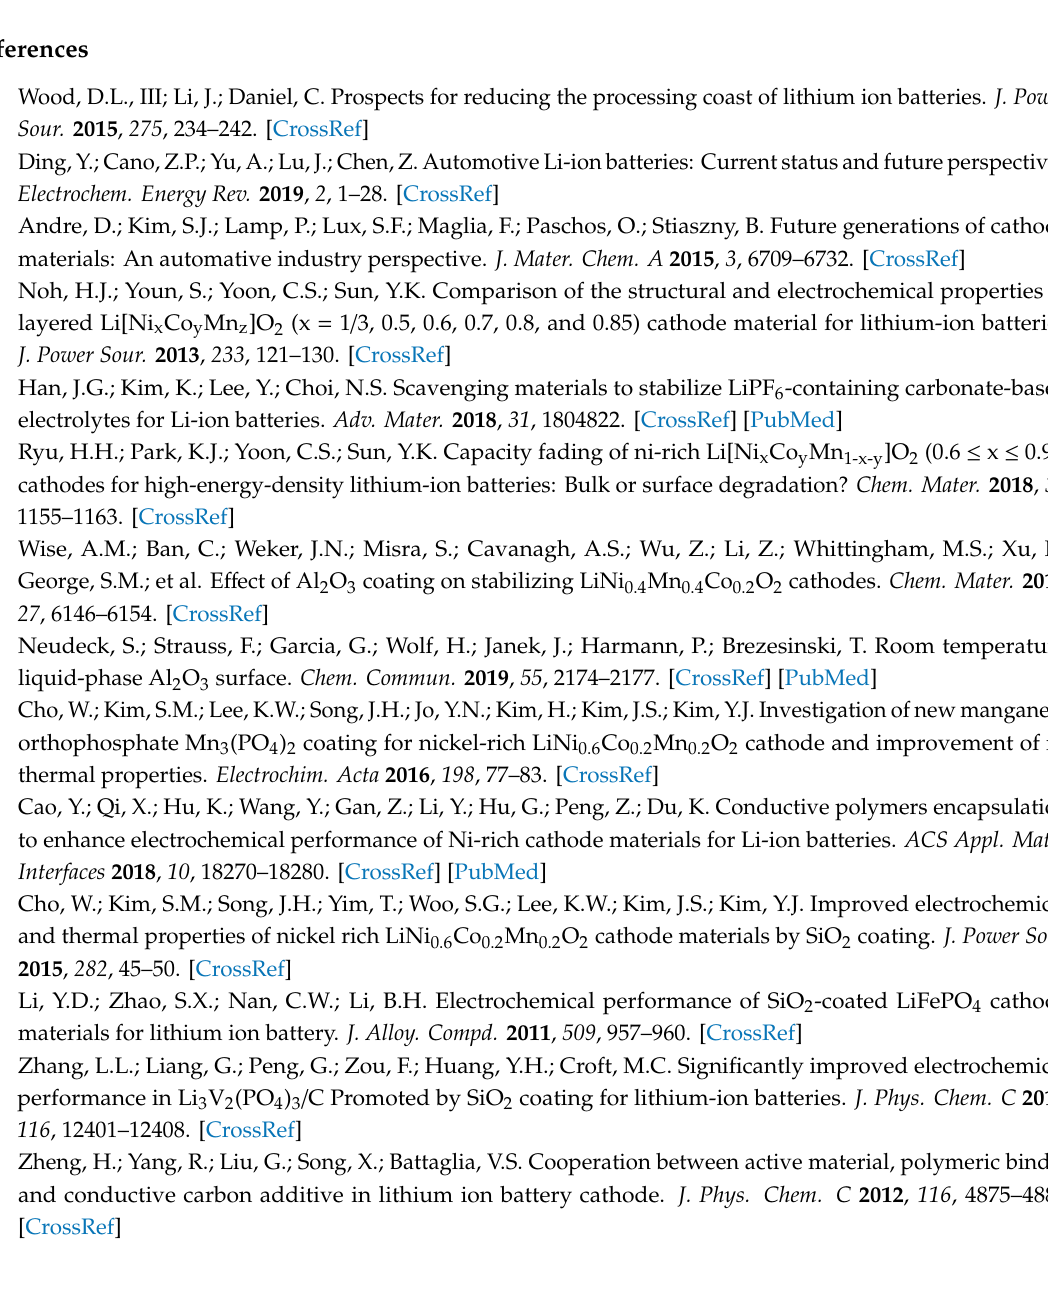
Figure S1: Comparison of rate capability between pristine and SiO 2 -coated NMC622; Figure S2: EIS measurements of the pristine and SiO 2 -coated NMC622 of both samples after formation cycles; Figure S3: Electrodes (diameter 15 mm) of ( a ) pristine and ( b ) SiO 2 -coated NMC622 material after 700 cycles; Table S1: The full width of half maximum (FWHM) of the main reflexes and crystallite size obtained by fitting the XRD